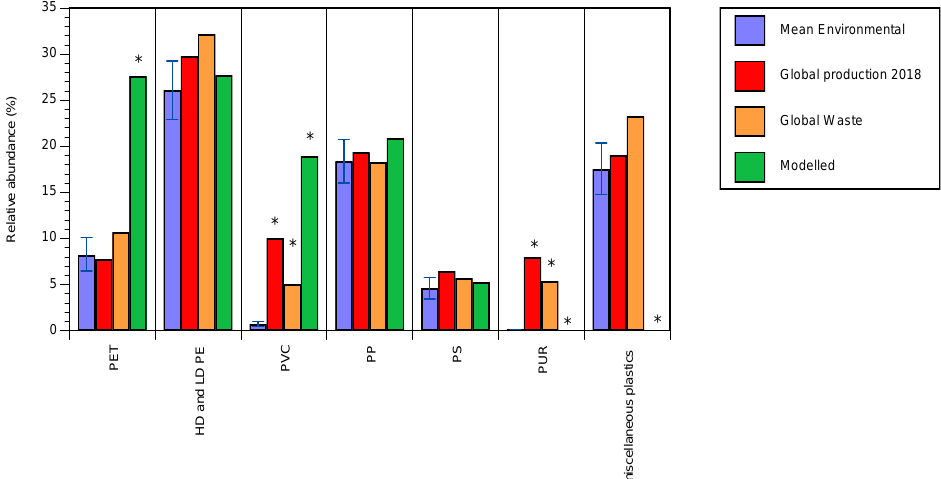
Figure 4. Relative abundance of polymers (mean % of particles ± SE) identified by studies of microplastics in freshwaters and estuaries compared with global production [2], estimated waste [9] and modelled release as microplastics to surface waters [3]. * Indicates a significant difference from environmental samples ( p ≤ 0.05 Bonferroni corrected).